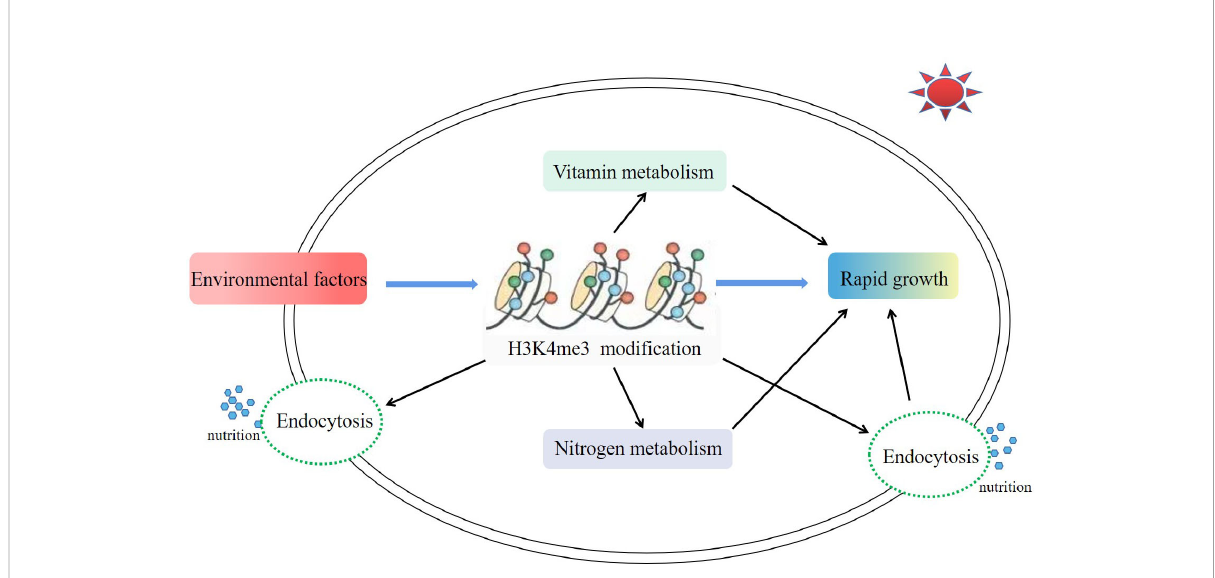
FIGURE 7 Major metabolic pathways associated with H3K4me3 in Alexandrium paci fi cum under high light and high nitrogen conditions. Environmental factors (high nitrate and high light intensity) enhanced the modi fi cation enrichment of H3K4me3. A higher enrichment level of H3K4me3 further promoted the vitamin metabolism, nitrogen metabolism, and endocytosis pathways, and fi nally promoted the rapid growth of A. paci fi cum